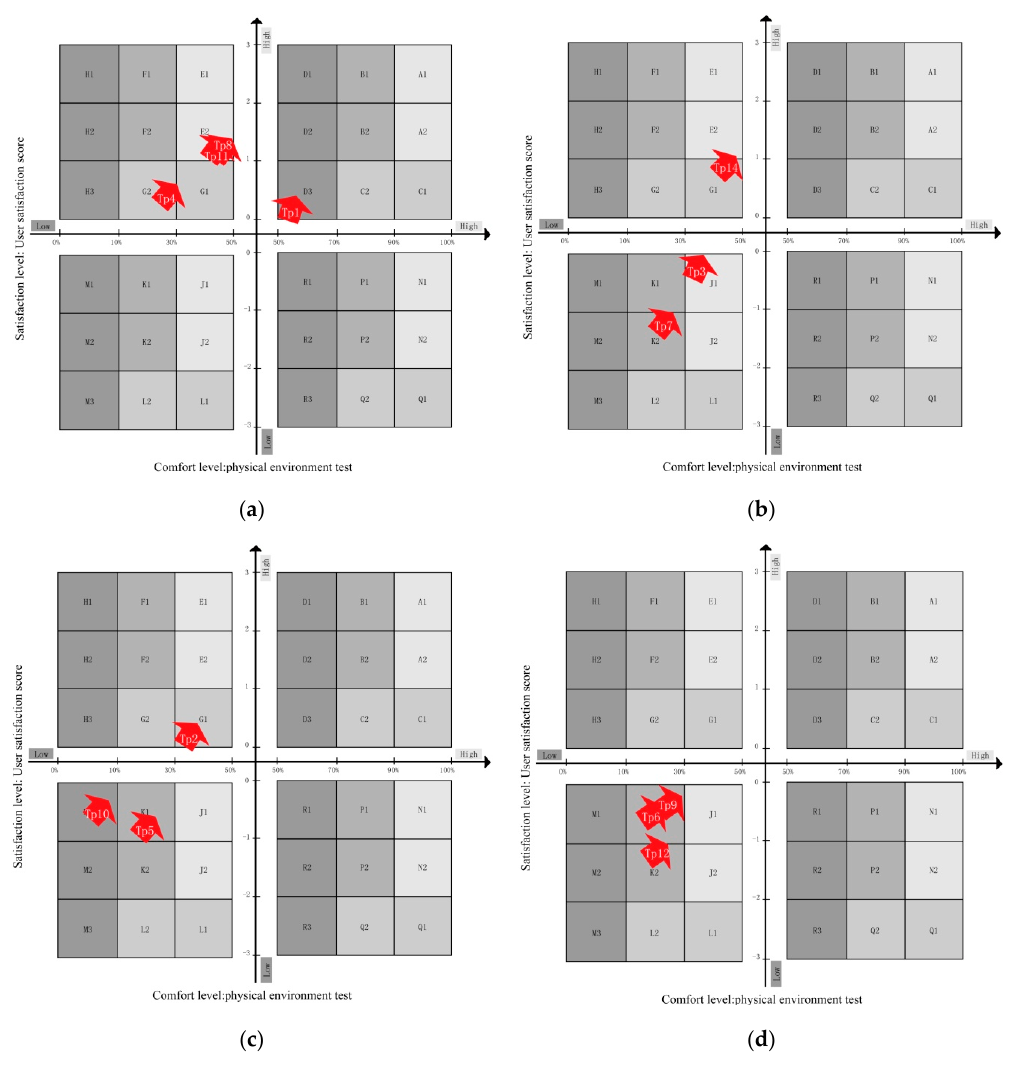
Figure 16. Test Point Satisfaction-Comfort Matrix results. ( a ) Middle tubular space; ( b ) Tube entrance (connection to building); ( c ) Tube entrance (connection to subway); ( d ) In subway station.